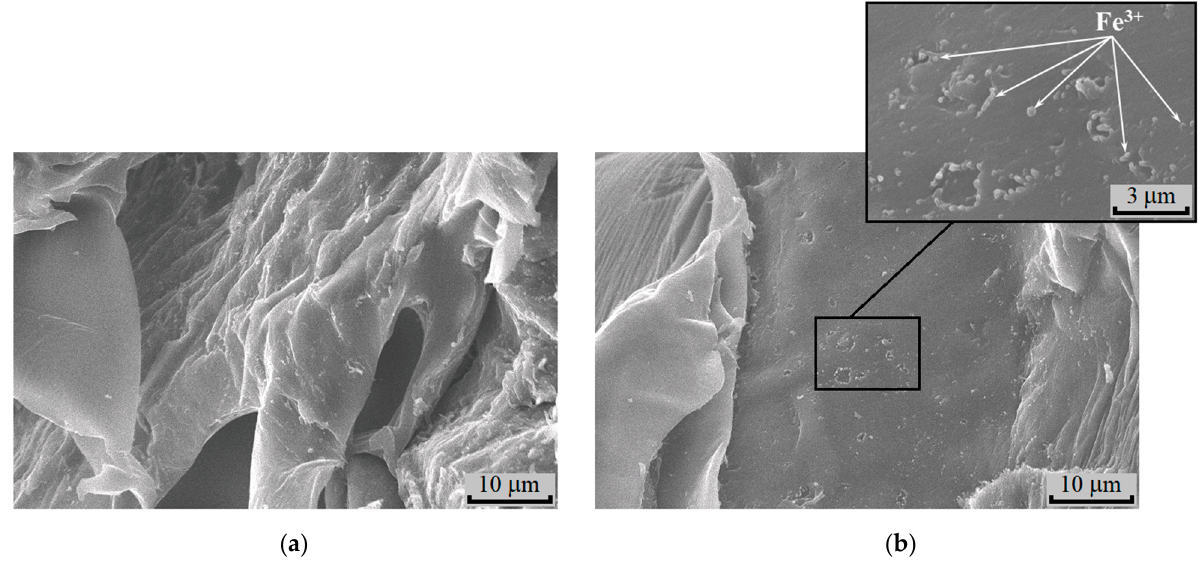
Figure 9. SEM micrographs of the initial films PLA-chitosan (50:50, wt. %) ( a ) and after sorption ( b ) from 0.3 mol/L FeCl 3 solution.